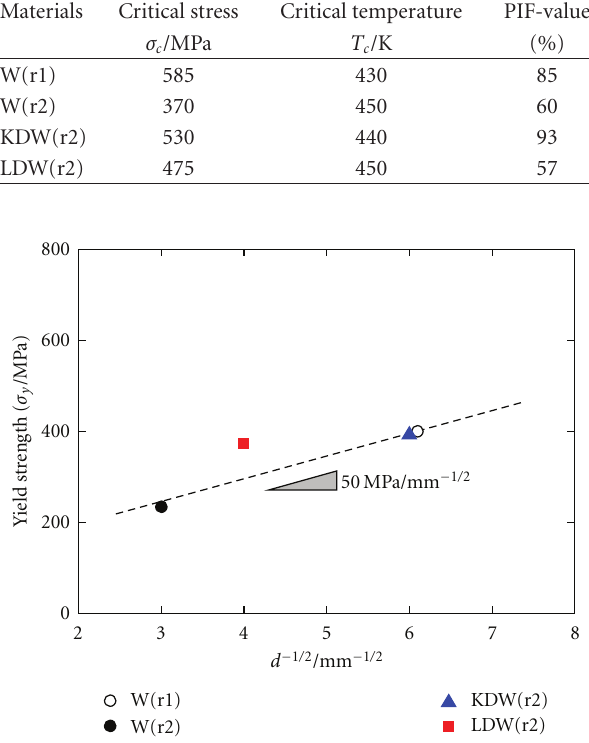
Figure 6: Grain size dependence of yield strength for various mate- rials.